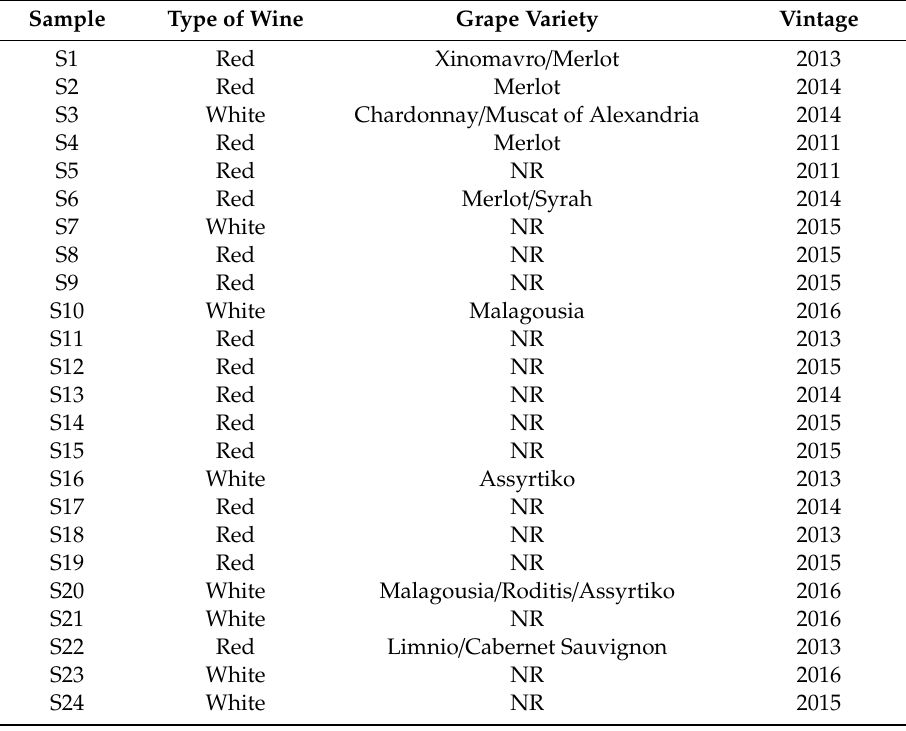
Table 1. Sample description of the tested wines from the region of